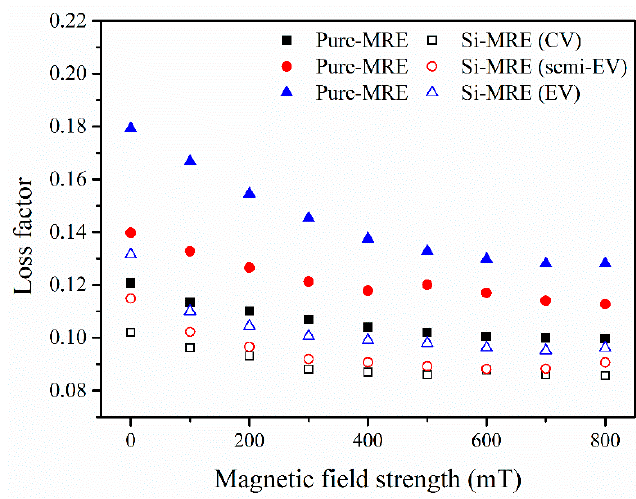
Figure 9. Loss factor of the MRE and Si-MRE for different vulcanization systems as a function of magnetic field.